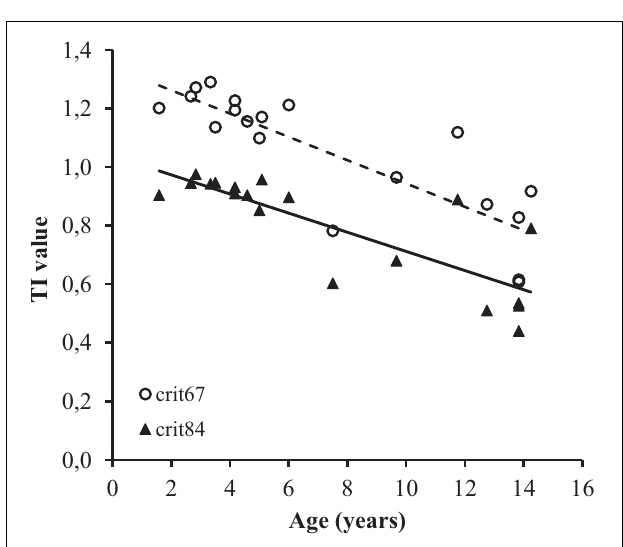
FIGURE 4 | TI values as a function of the Age of the participants and Learning Criterion. The dotted line corresponds to the criterion